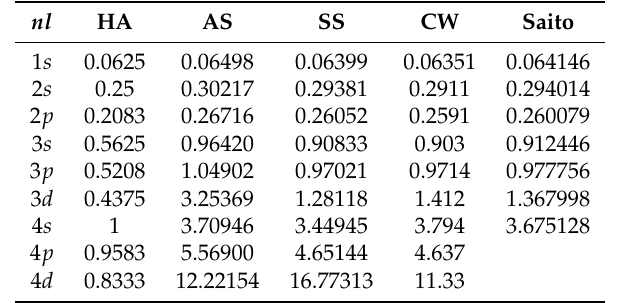
(cid:10) (cid:11) r 2 calculated by the Hydrogenic approximation (HA) and by the